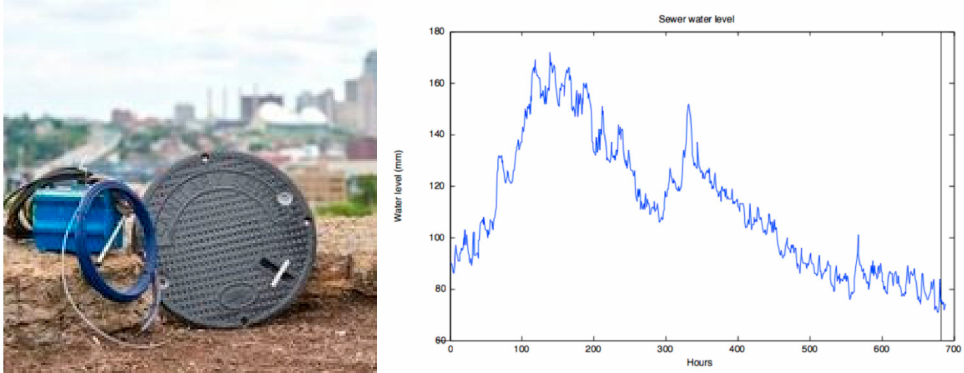
Figure 9. Smart manhole cover ( left ) [125] and example of measured sewerage water level ( right )